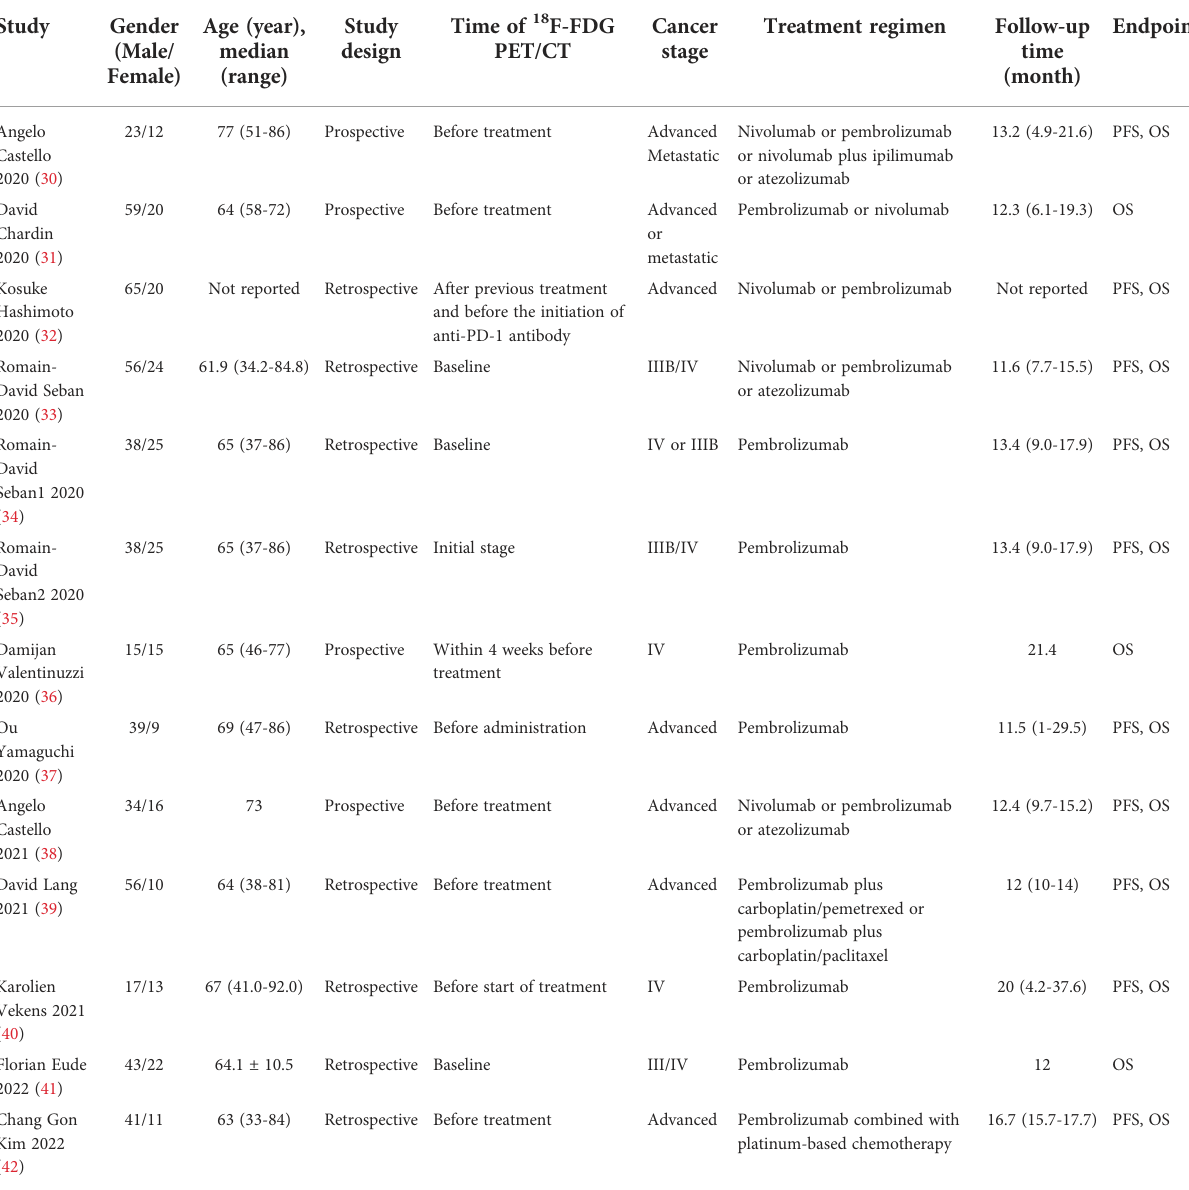
TABLE 1 The principal characteristics and details of eligible